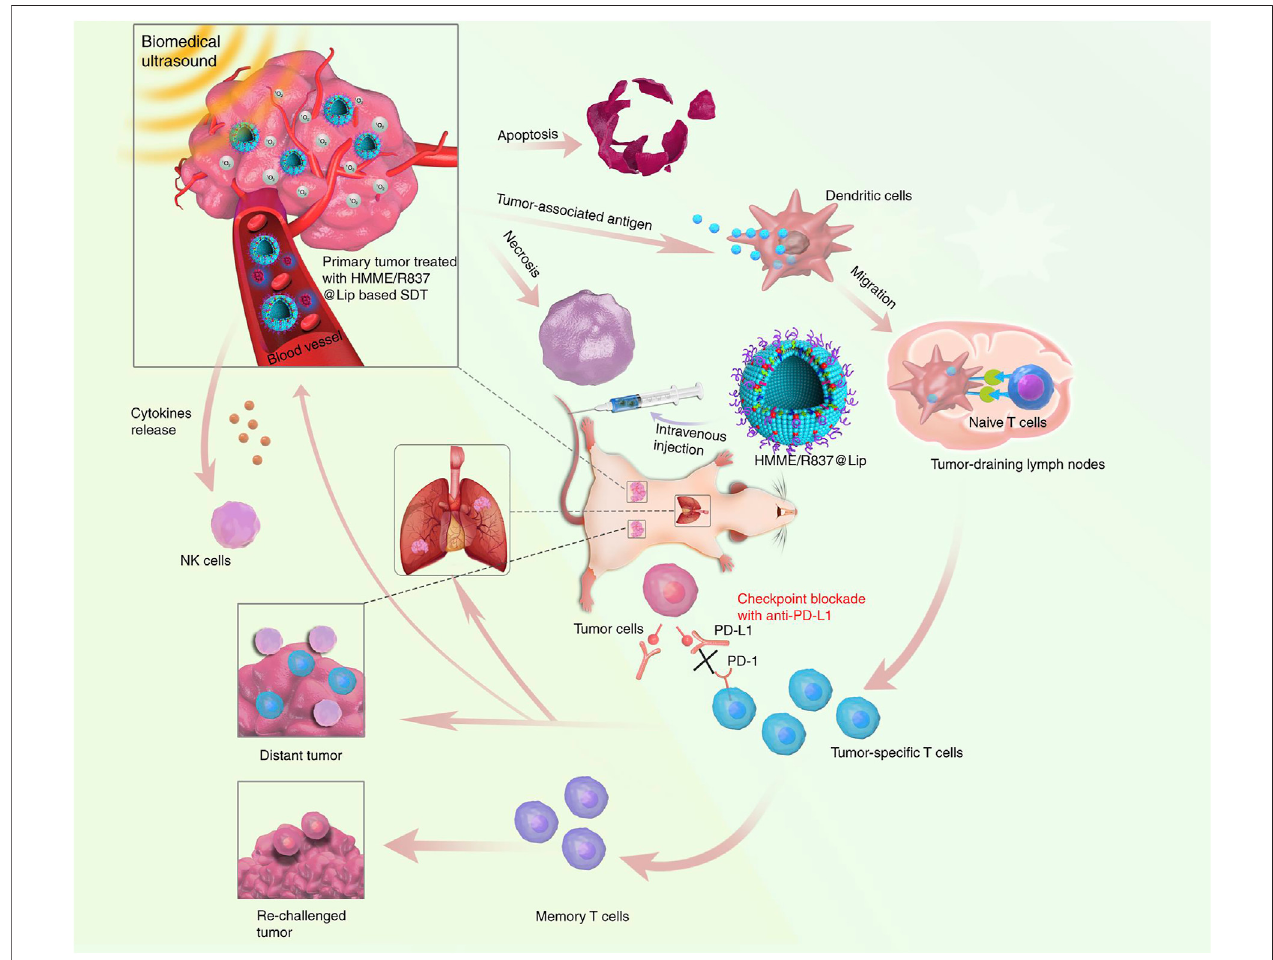
FIGURE 2 | Design principle of nanosonosensitizer-augmented synergistic SDT and immunotherapy. Schematic illustration of antitumor immune responses induced by combined noninvasive SDT with immune adjuvant – contained nanosonosensitizer and checkpoint blockade for effective cancer immunotherapy. Reproduced, with permission, from Yue et al. (2019). Copyright 2019, Nature Publishing Group.